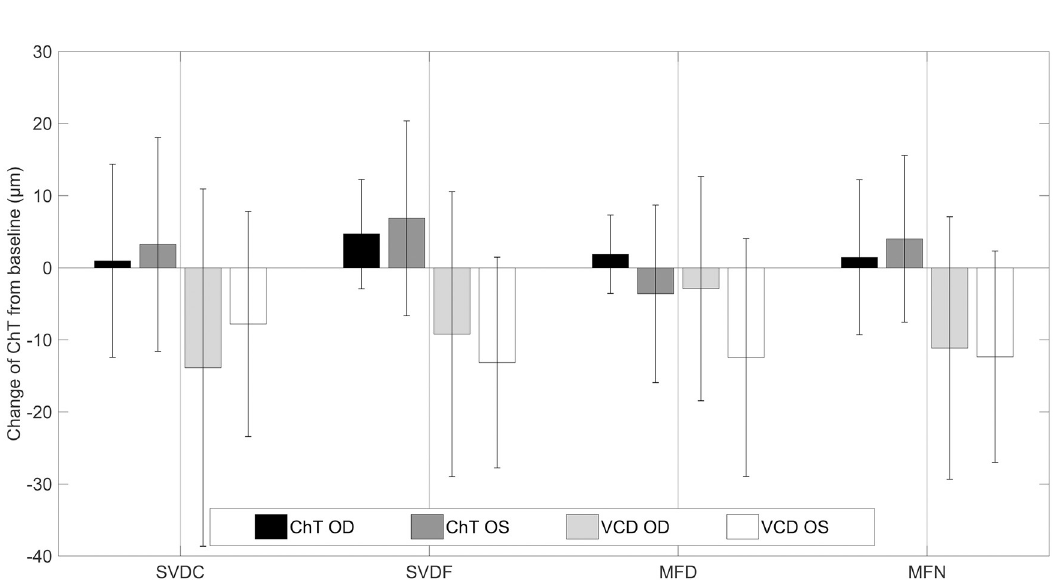
Fig 7. Choroidal and vitreous chamber depth (VCD) changes. Comparison of the lens-induced changes on the central ChT and vitreous chamber depth (VCD) between both eyes for every applied contact lens. General shortening from baseline of the vitreous chamber depth versus thickening of the choroid, whereas the left eye most commonly showed higher response rates. Errorbars indicate the standard